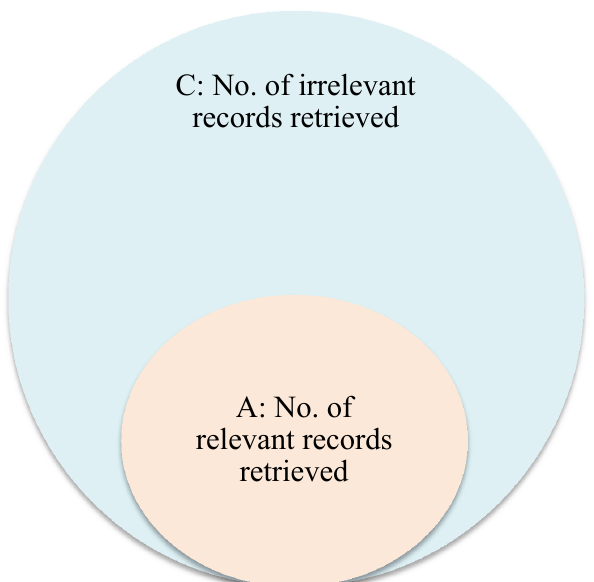
Fig. 2. The composition of Search